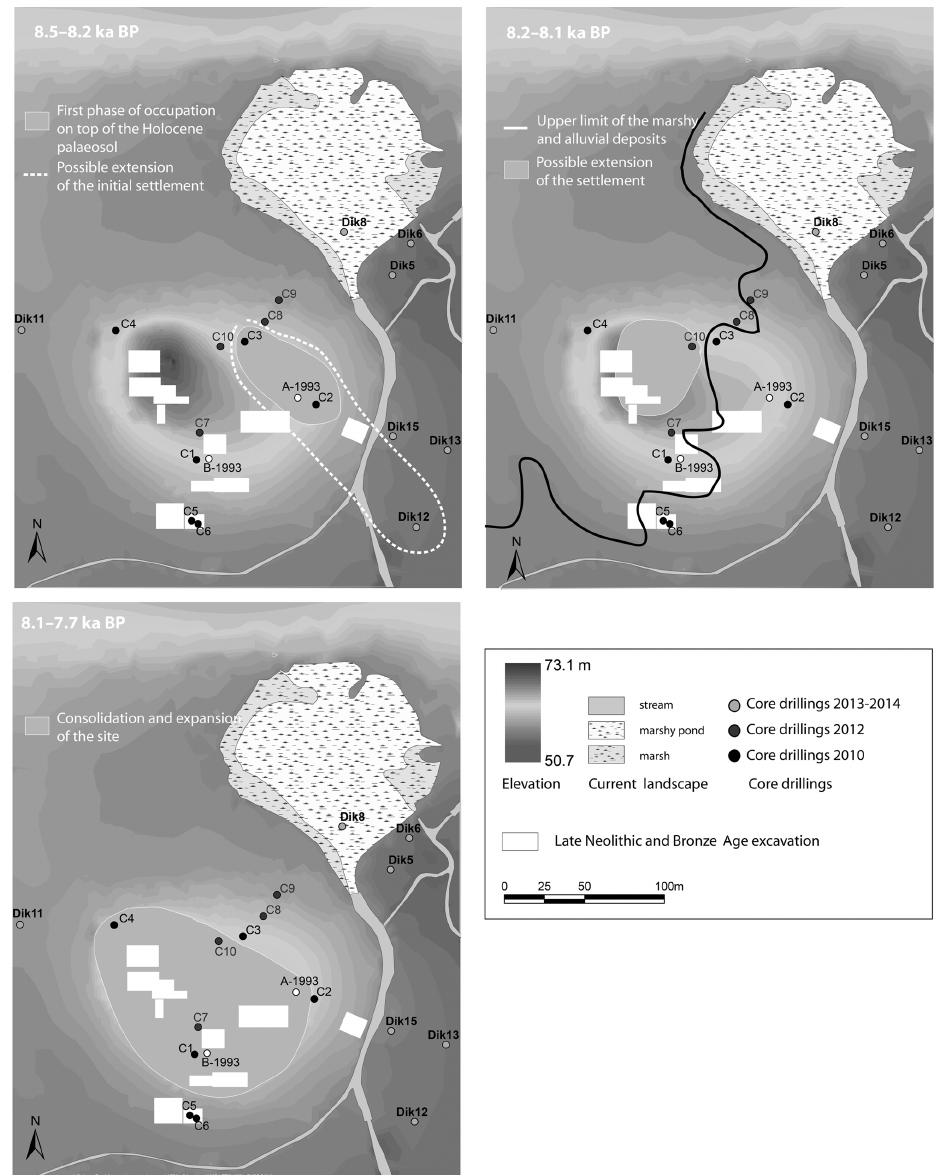
Figure 10. Map of the core drillings around Dikili Tash site and interpretation of the settlement dynamics during the early stages of the